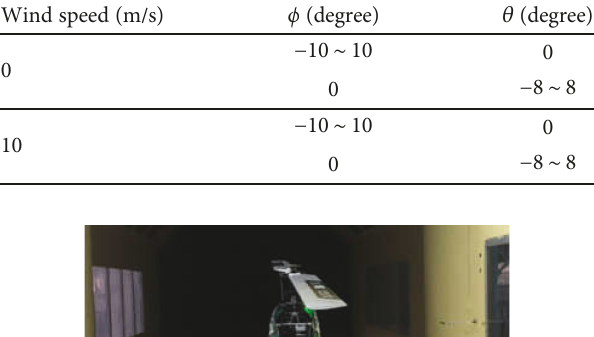
Table 6: The experimental scheme of the bracket experiment. Wind speed